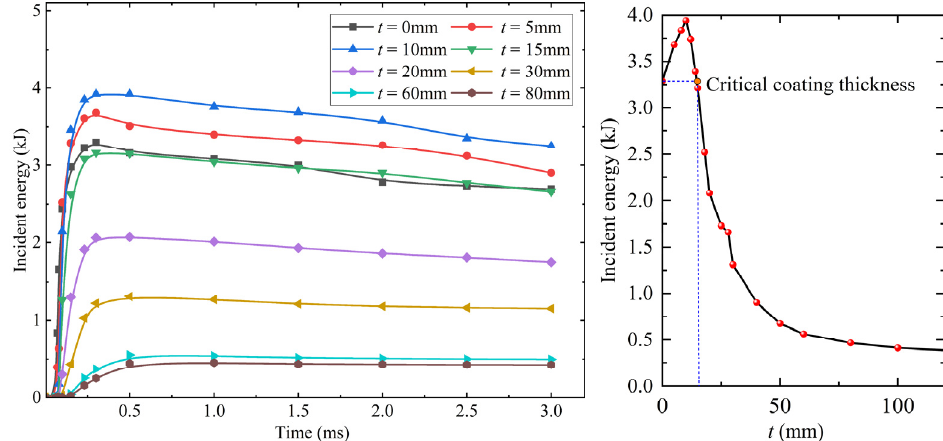
Figure 17. Energy incident into RC walls with different foamed concrete coating thicknesses.